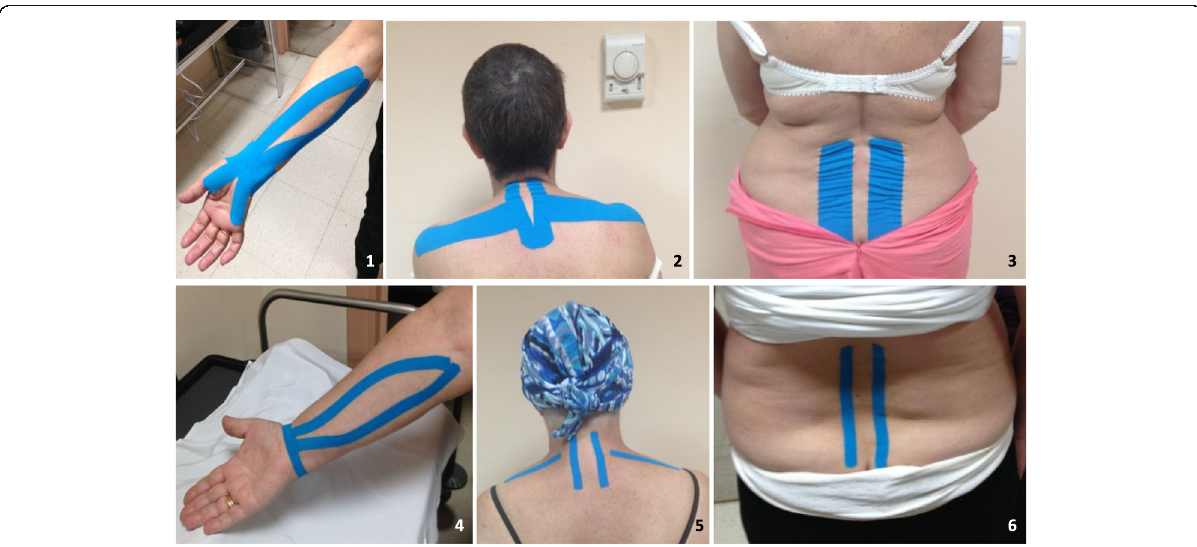
Fig. 1 Different applications of NMT; 1, Application for carpal tunnel syndrome. 2, Application for cervical pain. 3, Application for lower back pain. 4, Sham application for carpal tunnel syndrome. 5, Sham application for cervical pain. 6, Sham application for lower back